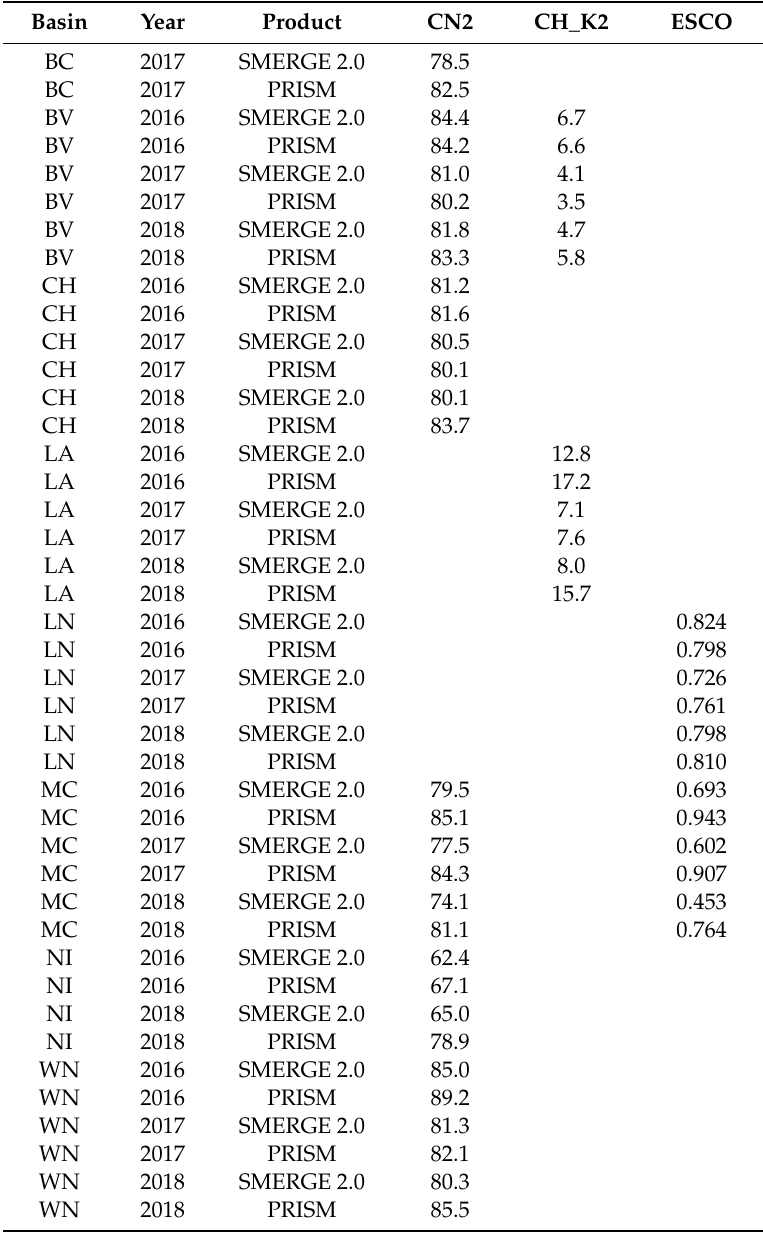
Table 9. Highly correlated parameter values for final calibration year-by-year (2016 to 2018)